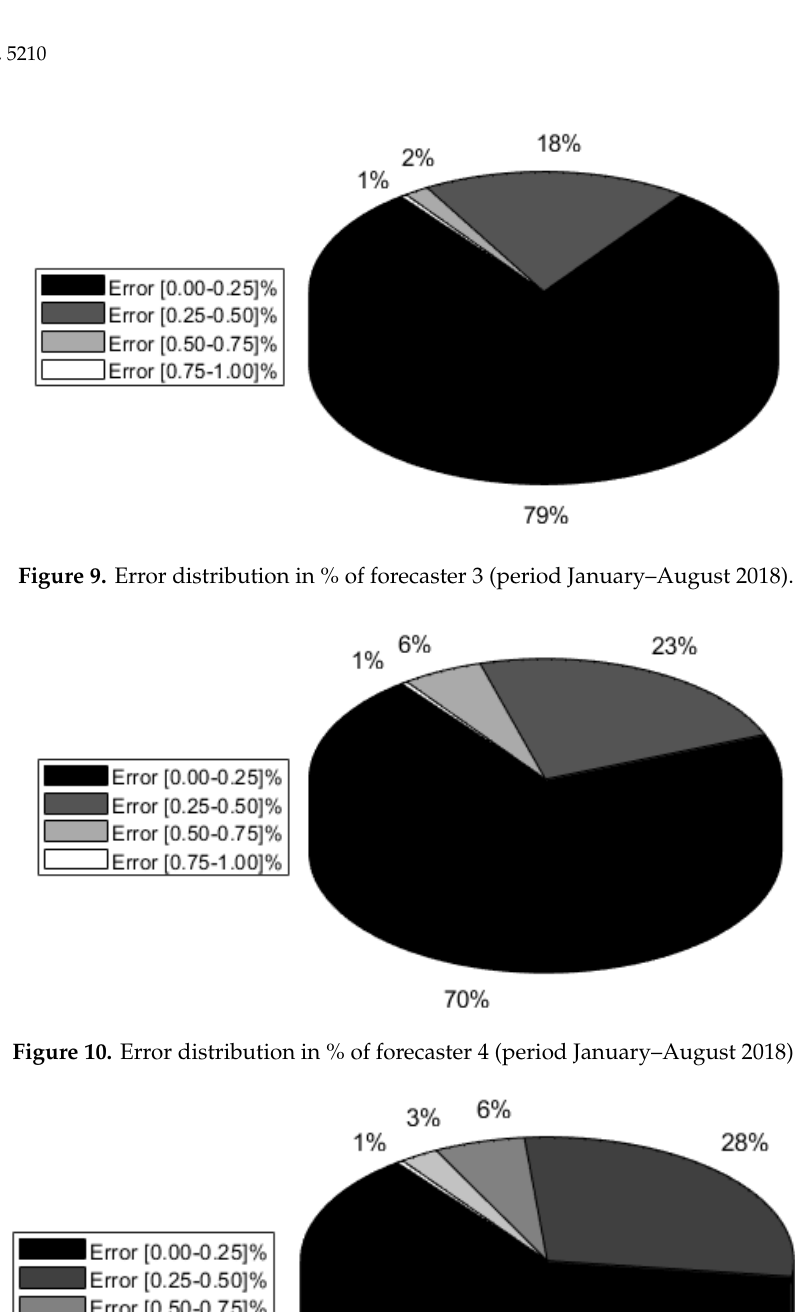
Figure 8. ( a ) Difference between real and predicted power demand on 31 August 2018 ( b ) accumulated energy.